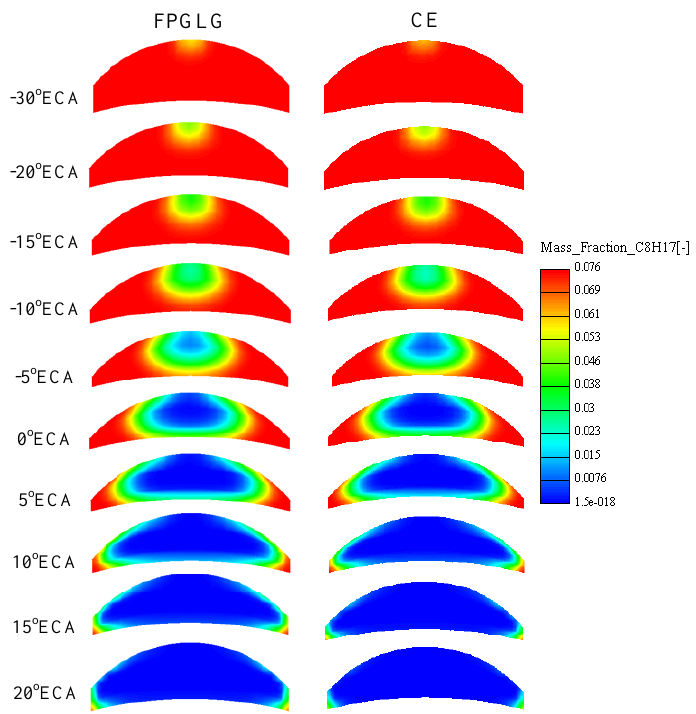
Figure 18. Combustion process comparison of the FPGLG and CE.